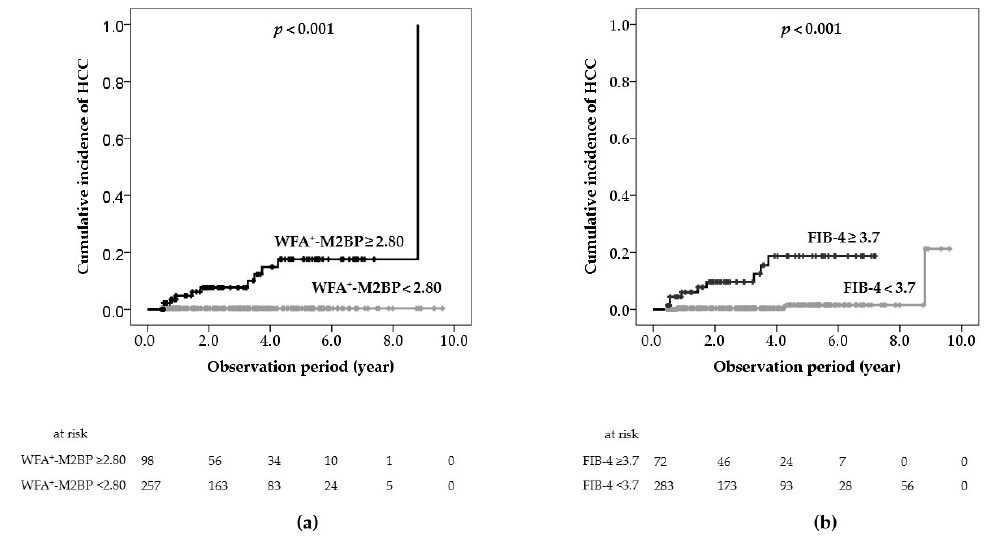
Figure 3. Cumulative incidence of hepatocellular carcinoma (HCC) development after sustained virologic response, shown according to serum Wisteria floribunda agglutinin-positive Mac-2-binding protein (WFA + -M2BP) level ( a ) or fibrosis-4 (FIB-4) index ( b ).